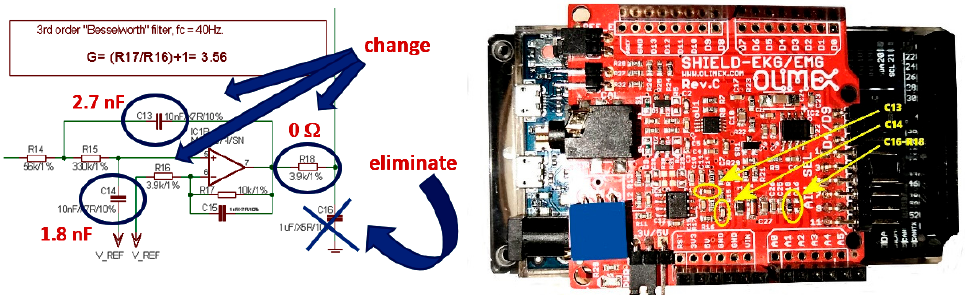
Figure 4. Changing the values of components for widening Olimex ECG/EMG shield